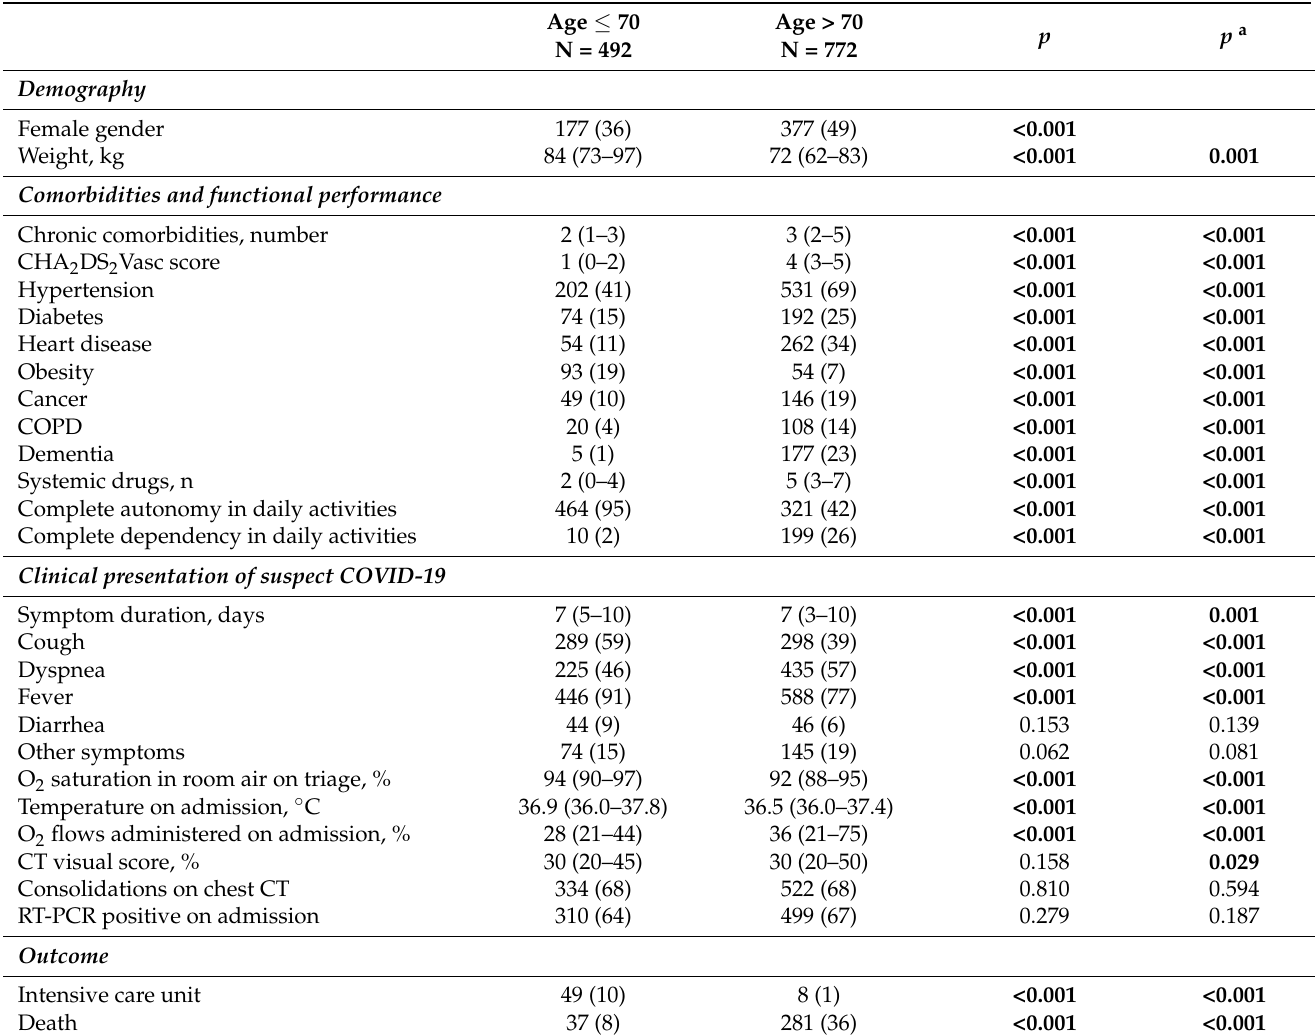
Table 3. Comparison of the demographic, anamnestic, clinical features, and outcomes of patients hospitalized for suspect COVID-19, categorized by age (>70 years old vs. ≤ 70 years